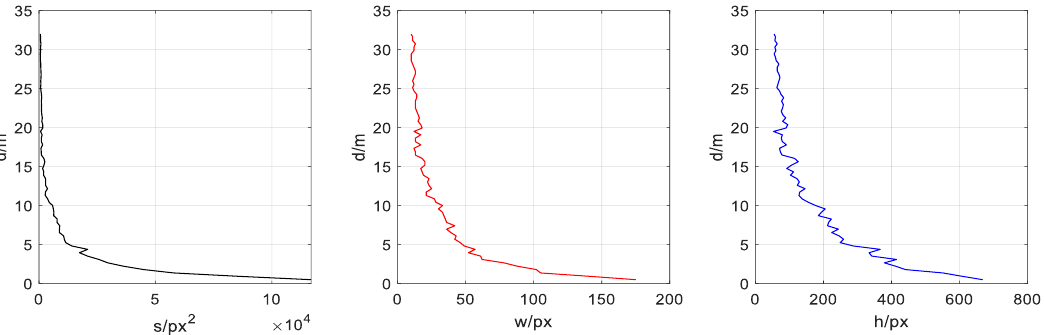
Figure 10. The curve diagrams of area s , width w , length h ,and distance d.